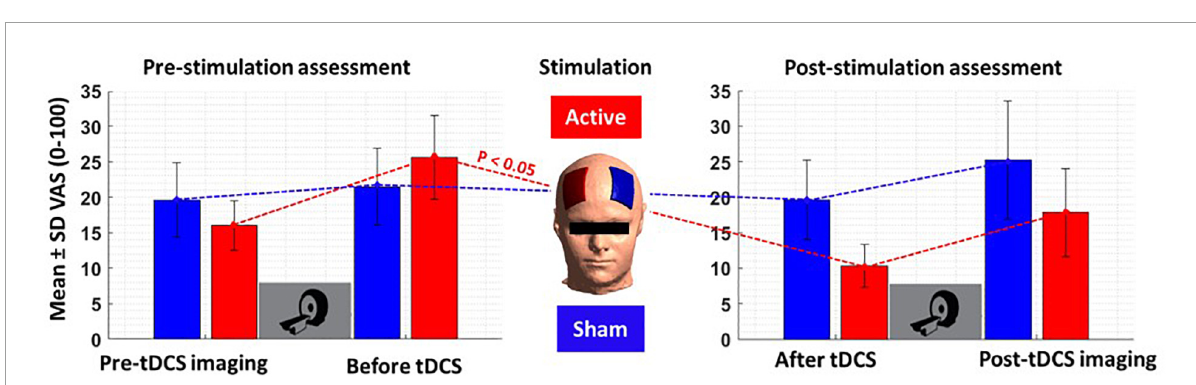
FIGURE7 Self-reported craving. Self-reported craving based on visual analog scale [VAS (0–100)] in four main time points; pre-tDCS imaging (before the first scan), before tDCS (after the first scan), after tDCS (before the second scan), and post-tDCS imaging (after the second scan). Bars show mean values, and error bars show the craving score’s standard deviation (SD). The craving score was significantly ( P < 0.05) decreased from before to after tDCS only in the active tDCS. The blue color is related to the sham condition, and the red is related to active tDCS.